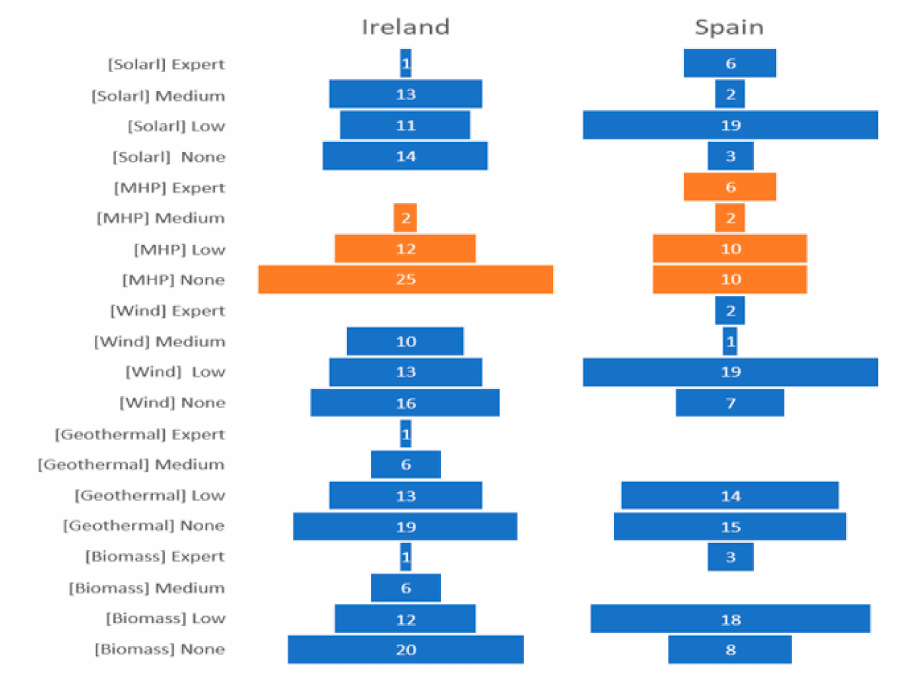
Figure 5. Knowledge of different RE technologies in Ireland and Spain (MHP in